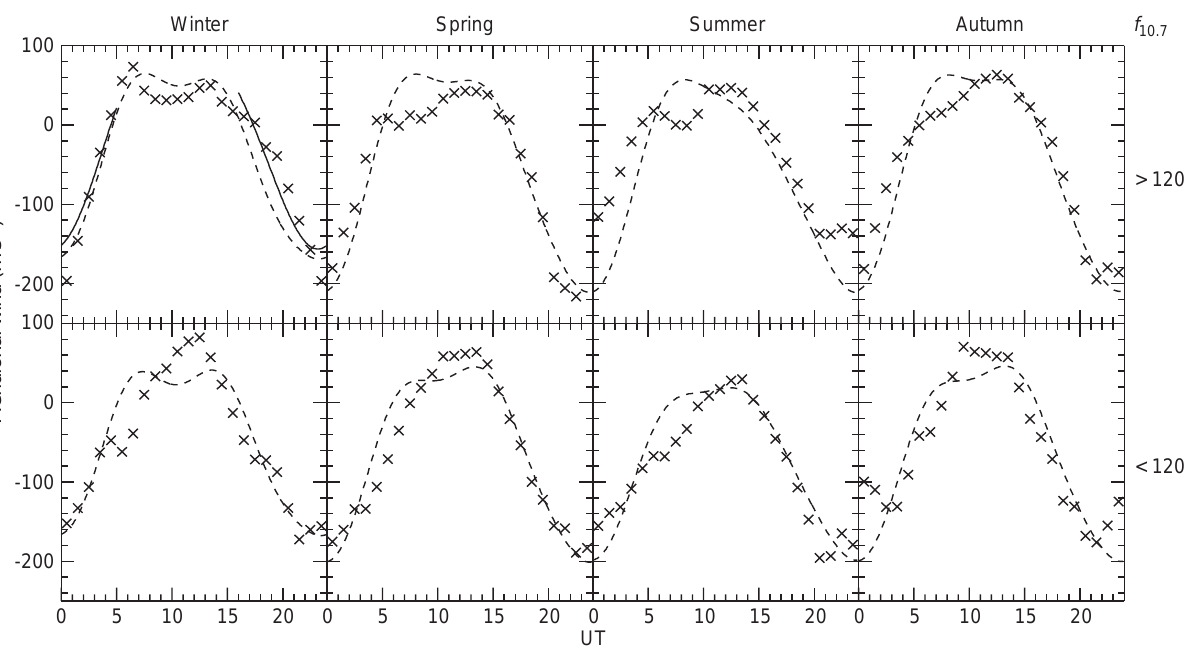
Fig. 7. Comparisons between the present work around 250 km height (the mean wind is represented by crosses ), the HWM model ( dashed line ) for the same geophysical conditions and the FTH model ( solid line ) in winter and during high solar activity period